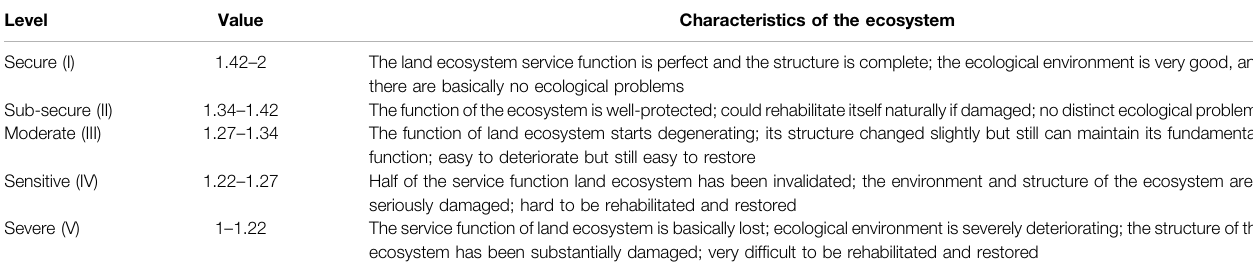
TABLE 3 | Land ecological security classi fi cation. Level Value Characteristics of the